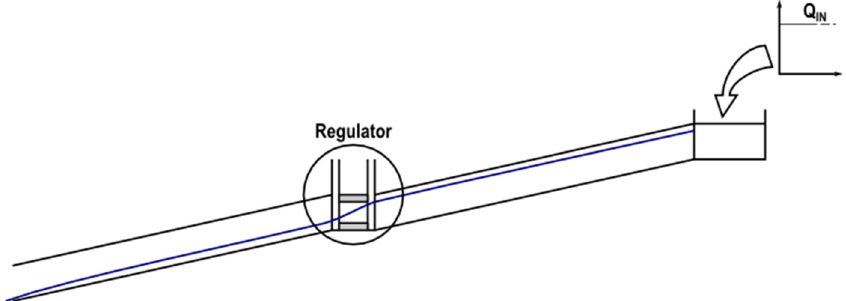
Figure 5. Network used for the exhaustive study of weirs and orifices.